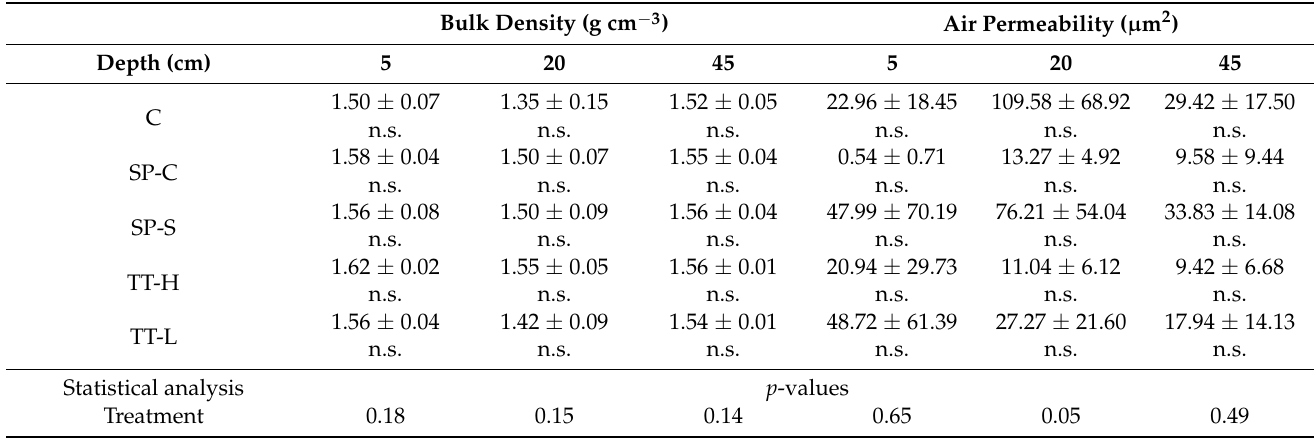
Table 7. Average bulk density (g cm − 3 ) and air permeability (µm 2 ) ± standard deviation ( n = 3) at 5 cm, 20 cm and 45 cm depth. The letters underneath the results indicate the statistical grouping ( p < 0.05) of the Tukey post-hoc test, n.s. points out insignificant differences.